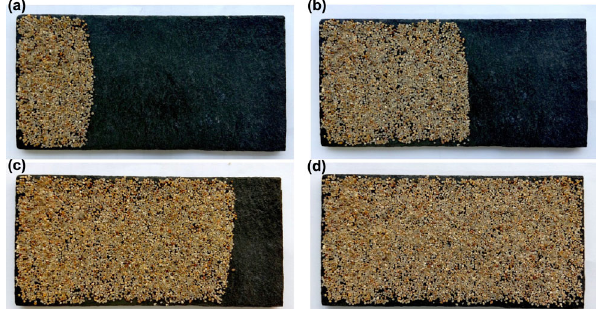
Fig. 6 The photographs of experimental operation that every time 1 g sand was gradually placed on lower shale rock, the particles were arranged tightly without stacking between particles, until 3.8 g sand took up the entire lower shale rock. (a) 1 g, (b) 2 g, (c) 3 g, and (d) 3.8 g.